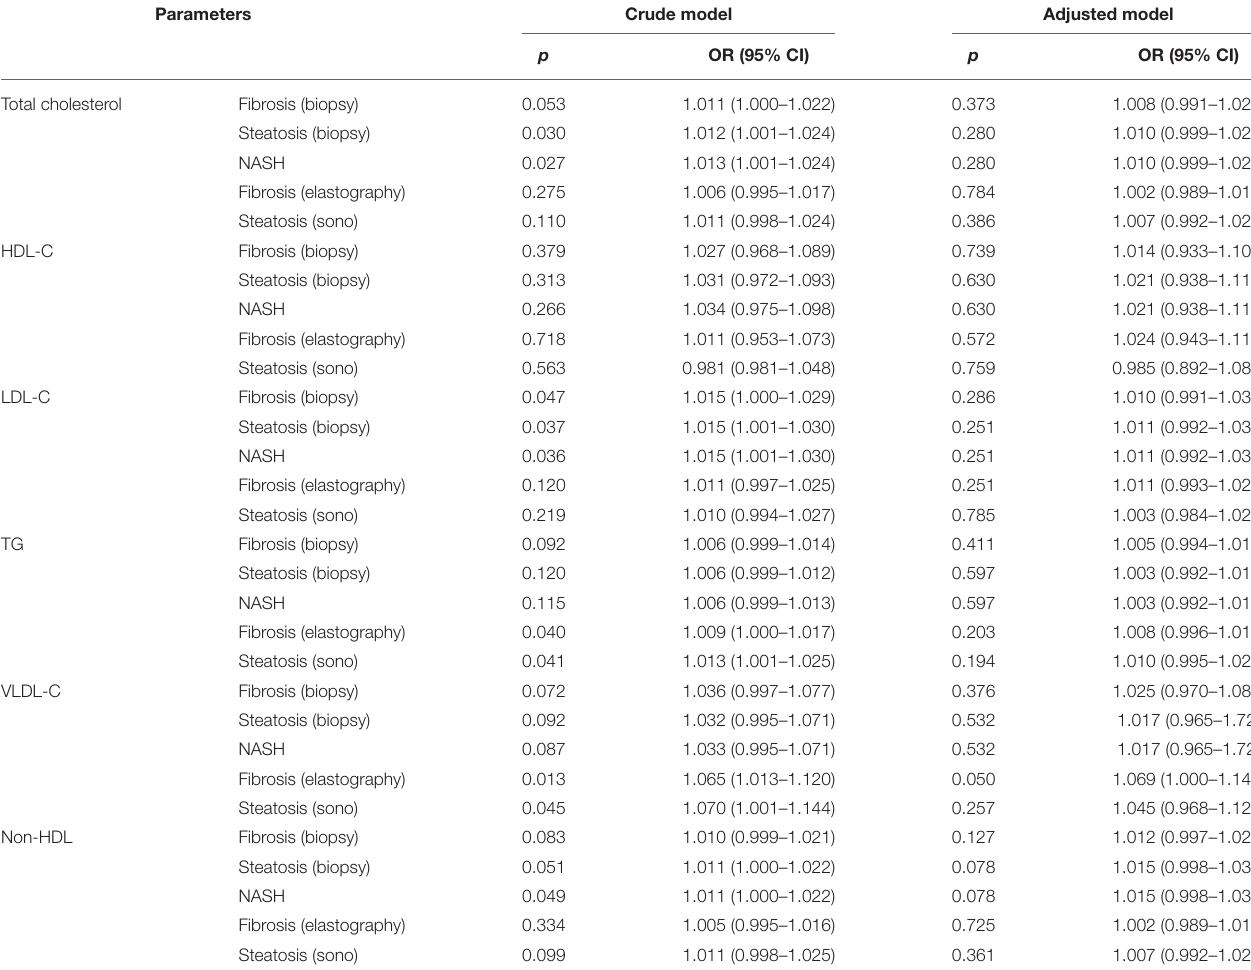
TABLE 5 | The binary logistic regression analysis between lipid profile and liver study